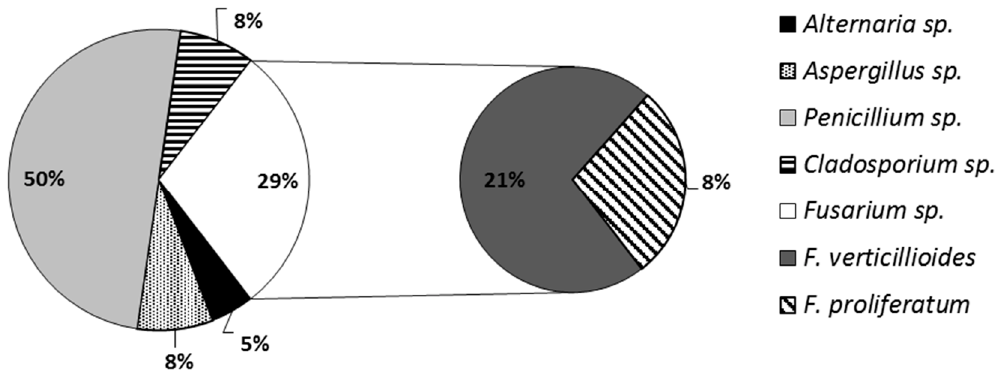
Figure 1. Percentage of fungi isolates identified in veterinary diets. Table 1. Characteristics of the cereal components present in veterinary diets for dogs and cats